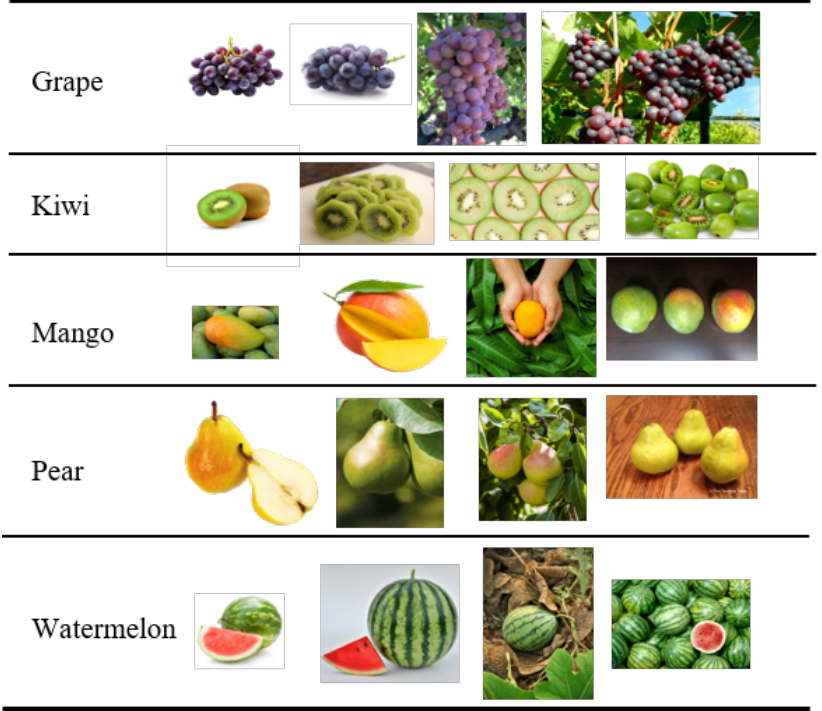
Figure 13. Examples of the FV dataset on six